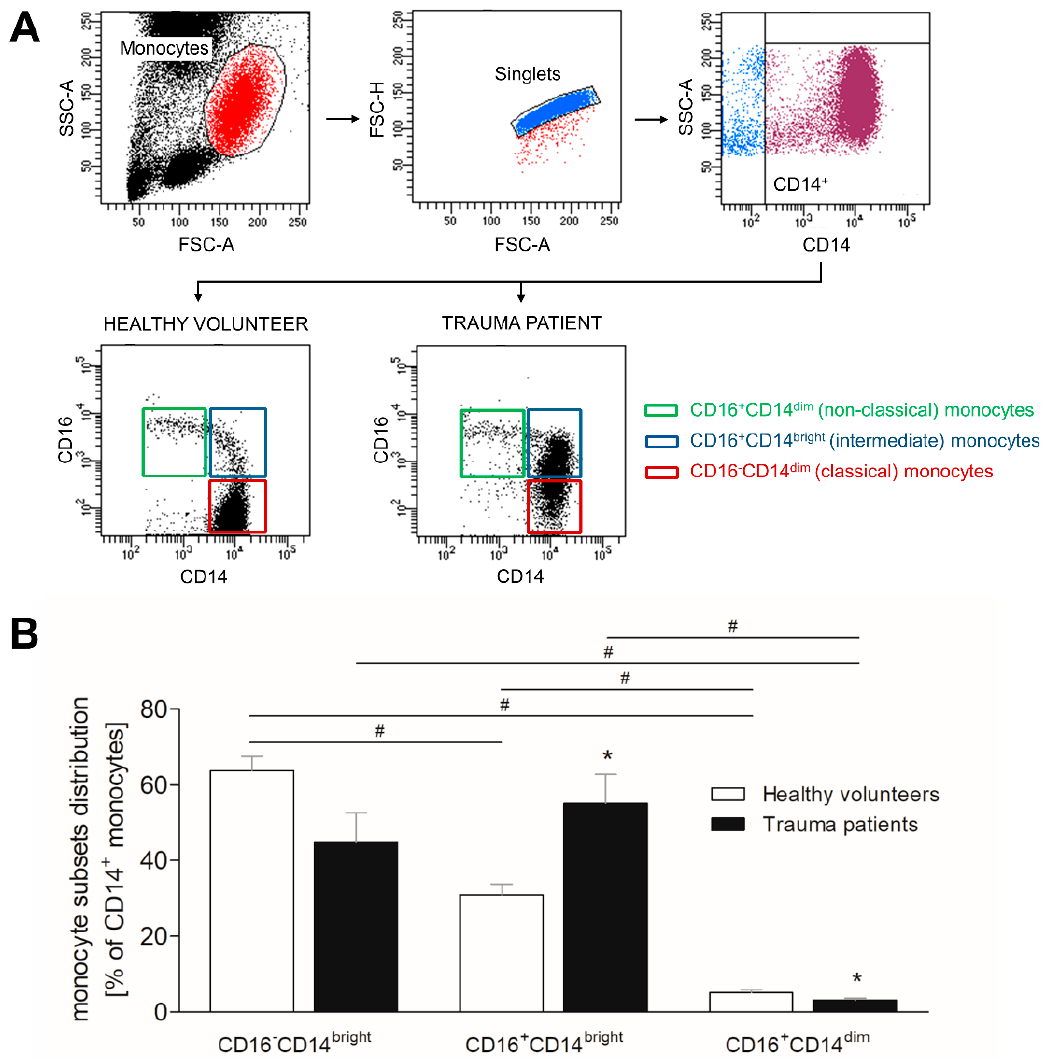
Figure 2. Impact of severe traumatic injury on monocyte subset distribution. ( A ) Representative gating strategy for phenotyping human monocyte subsets, including size discrimination, doublet exclusion, selection of CD14 + cells, and separation according to expression of CD16 and CD14. ( B ) The percentage distribution of CD14 bright CD16 − (classical), CD14 bright CD16 + (intermediate) and CD14 dim CD16 + (non-classical) monocytes out of CD14 + monocytes was determined in healthy subjects (white bars) and severely injured patients (black bars) within 12 h postinjury. Data are presented as mean ± standard error of the mean. *: p < 0.05 vs. healthy volunteers; #: p < 0.05 vs. respective subset.